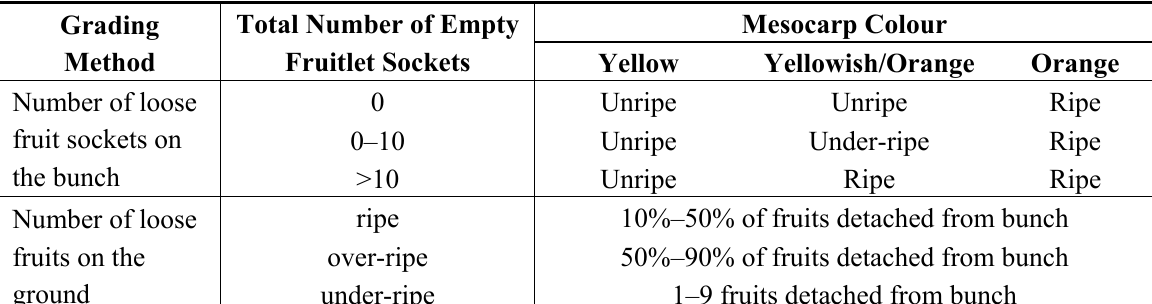
Table 1. Grading standard used by MPOB [17].